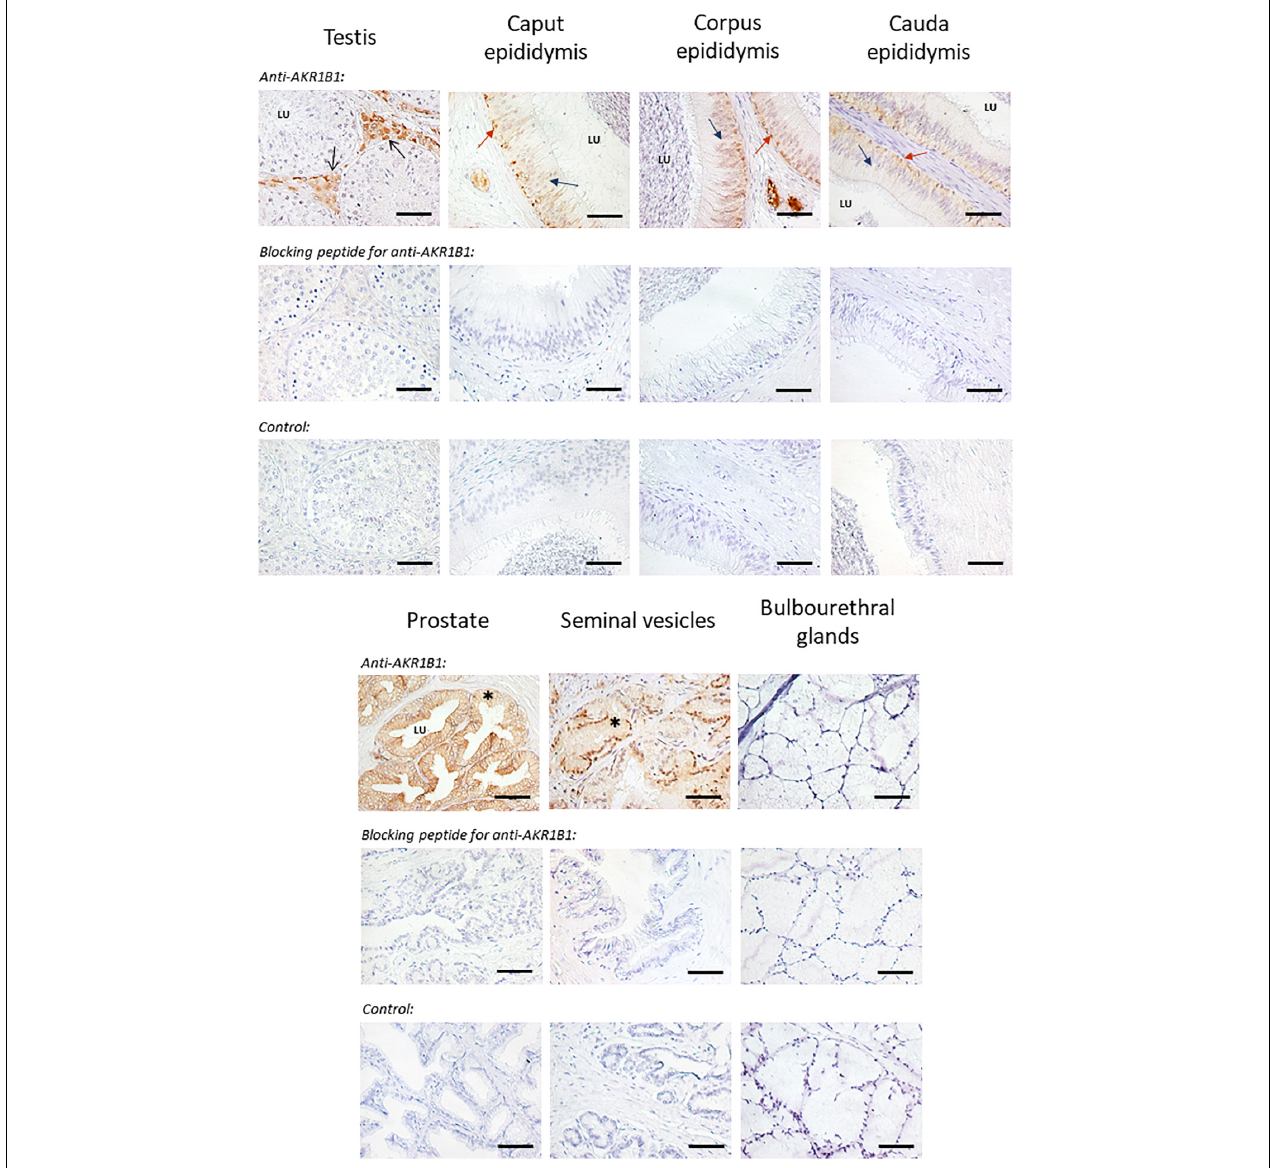
FIGURE 3 | Immunohistochemistry of AKR1B1 in boar genital organs (testis, caput, corpus, and cauda from the epididymis, prostate, seminal vesicles, and bulbourethral glands). The first row shows anti-AKR1B1 staining in each tissue. Specifically, Sertoli cells from testis (black arrow), principal (blue arrow), and basal cells (orange arrow) in the epididymis and glandular cells from prostate and seminal vesicles (indicated as *) appeared stained. Specificity of the primary antibody in all tissues/organs was confirmed by the absence of signal in blocking peptide assays (second row). Finally, negative control (third row) proved the specificity of the secondary antibody. LU, lumen. Scale bar = 50 µ